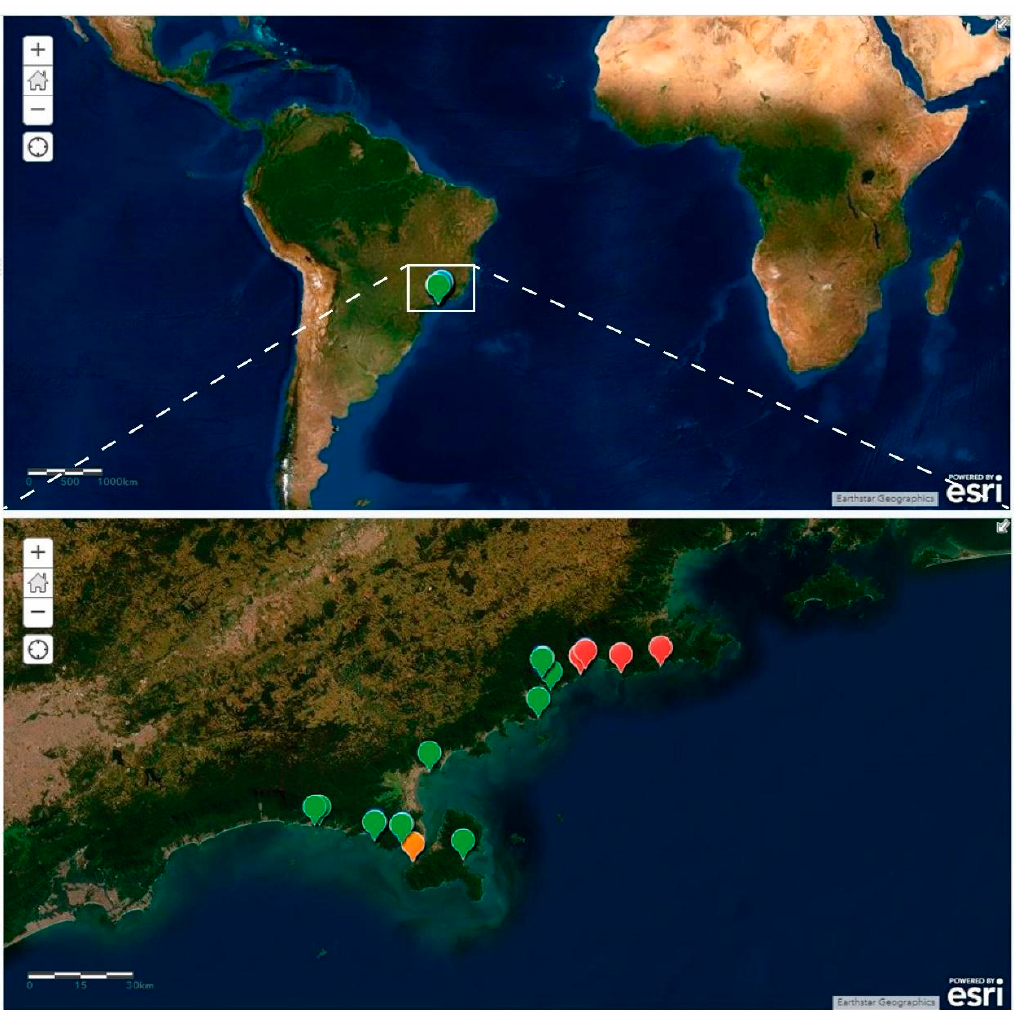
Figure 1. Map of Brazil showing the distribution of Paraturbanella species. Red: Paraturbanella tricaudata species nova (sp. nov.). Green: Paraturbanella sp. 1 [34,35]. Orange: Paraturbanella sp. 3 [34].